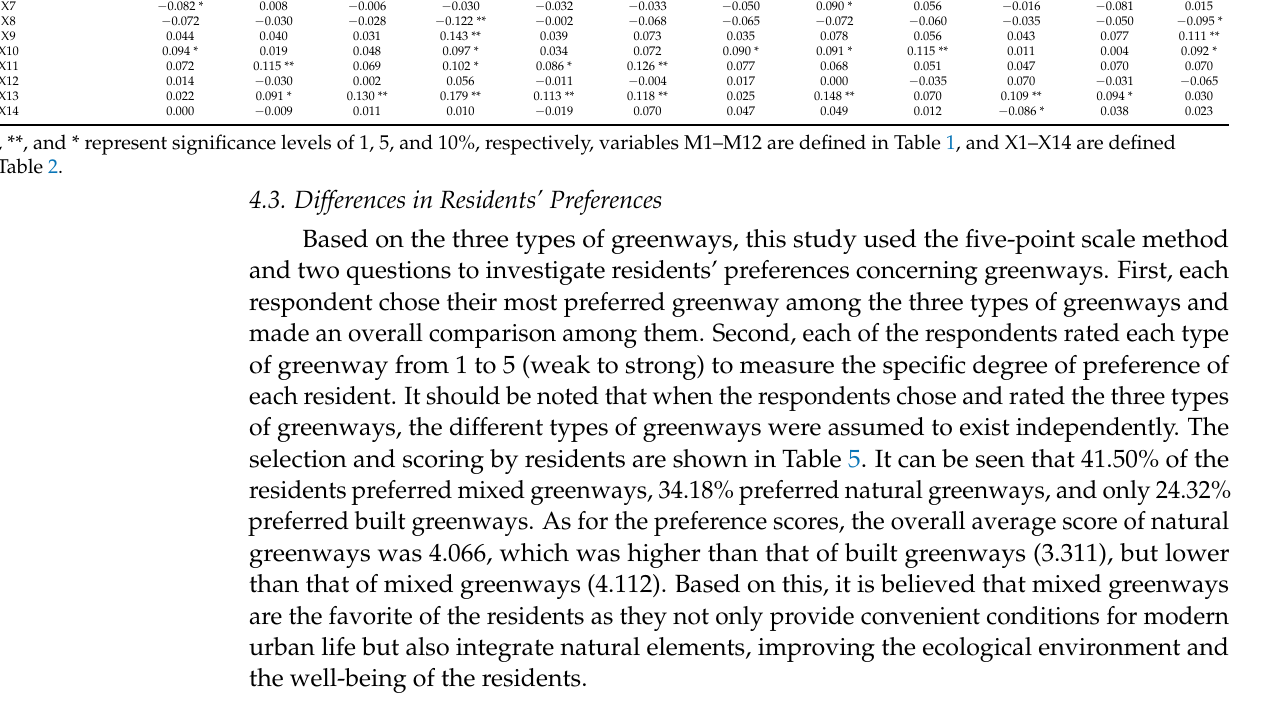
Table 5. Preferences of residents for three types of urban